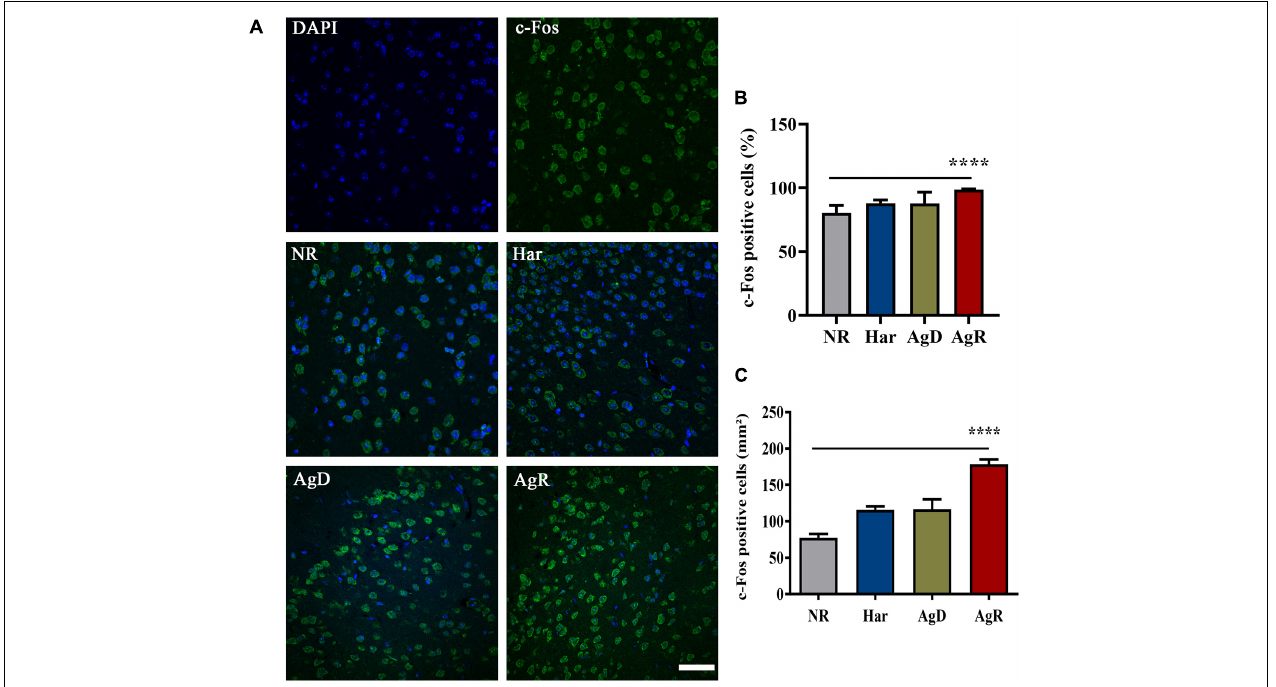
FIGURE 8 | Expression of the c-Fos protein in the cerebral cortex of mice submitted to the MSA. (A) Representative image showing nuclear staining with DAPI (blue) and c-Fos protein staining (green). Merging of c-Fos and DAPI staining is indicative in the categories of not regrouped (NR), harmonic (Har), attacked (AgD) and aggressor (AgR) in the cerebral frontal cortex. Bar: 50 urn. (B) Quantification of the percentage of cells positive for c-Fos. (C) Quantification of c-Fos-positive cells by the extension (mm2) of the cerebral frontal cortex area according to the categories NR (gray bar), Har (blue bar), AgD (green bar) and AgR (red bar) (NR; n = 15, Har; n = 20, AgD; n = 25, AgR; n = 15 animals). Values are expressed as the percentage and mean ± standard deviation (SD) of three independent experiments. **** corresponds to the statistical significance ( p < 0.0001) between AgR and the other categories by Kruskal-Wallis and Dunn’s